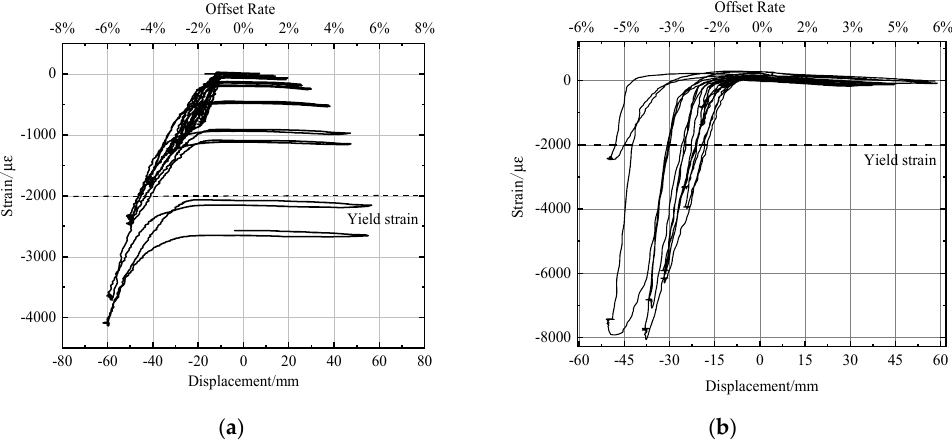
Figure 19. Section assembly CFST bridge pier steel pipe part strain, ( a ) CFST − R test specimen, ( b ) CFST − 0 test